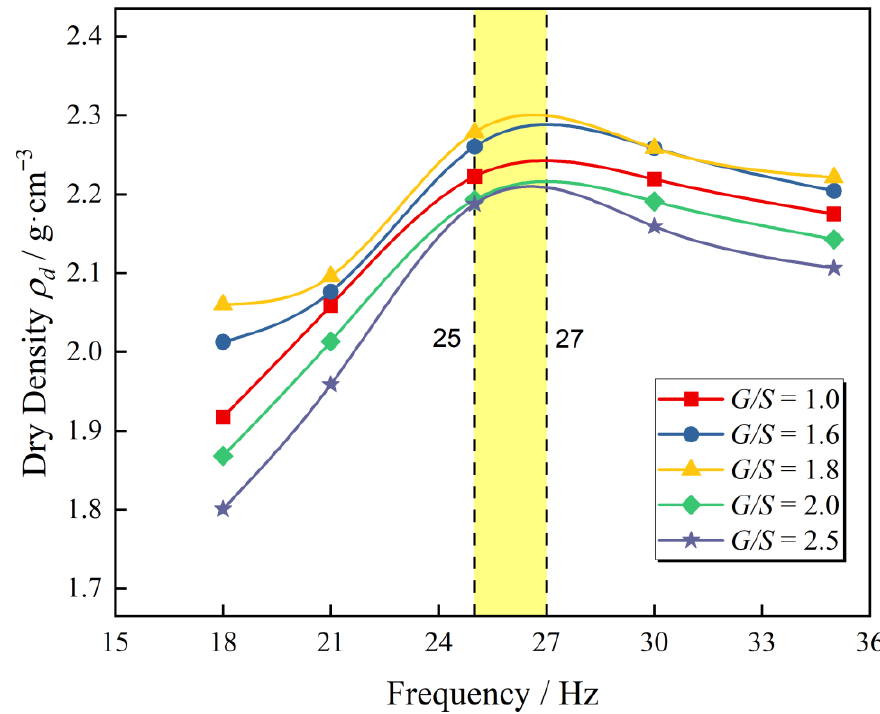
Figure 8. The curves of achieved dry density versus vibratory frequency from new plate vibratory compaction tests.